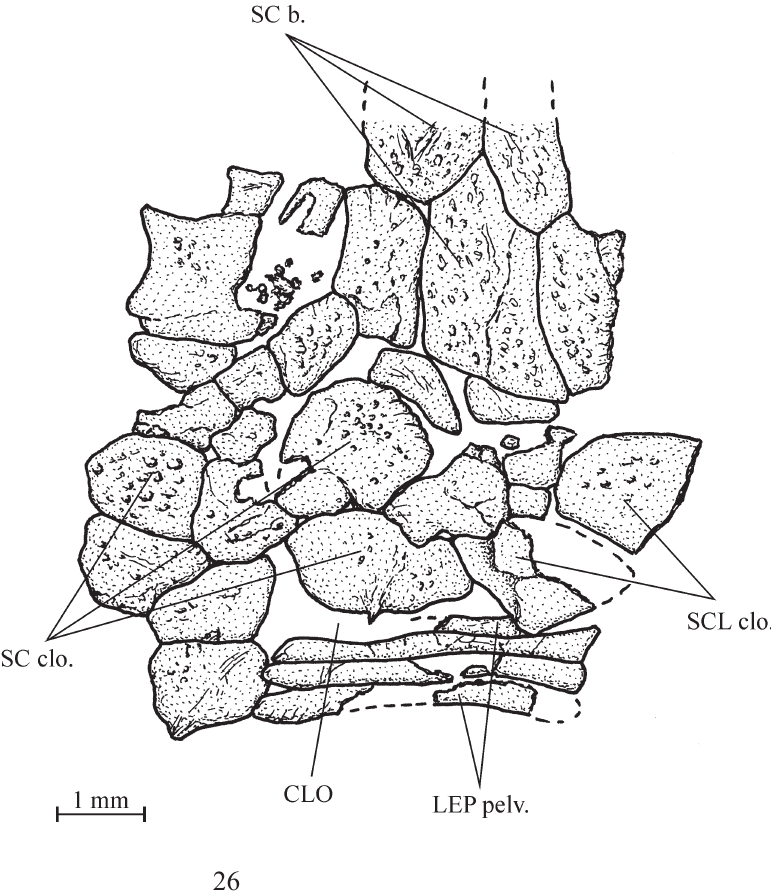
Fig. 23. Brembodus ridens Tintori, 1980. Sample CLC J-420. A . Scale of the dorsal region. B . Scale of the ventral region.